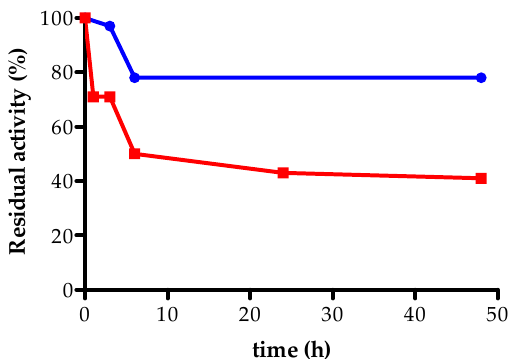
Figure 2. Stability of immobilized AXE on acrylic epoxy resin (red squares) and on glyoxyl-agarose (GLX-AG) (blue circles) in 50% acetonitrile. The measurements have been performed in duplicate. 2.2. Enzymatic Hydrolysis of Peracetylated Monosaccharides ( 1 – 8 ) The enzymatic regioselective hydrolysis of different peracetylated D -mannopyranoses ( 1 – 7 ) and